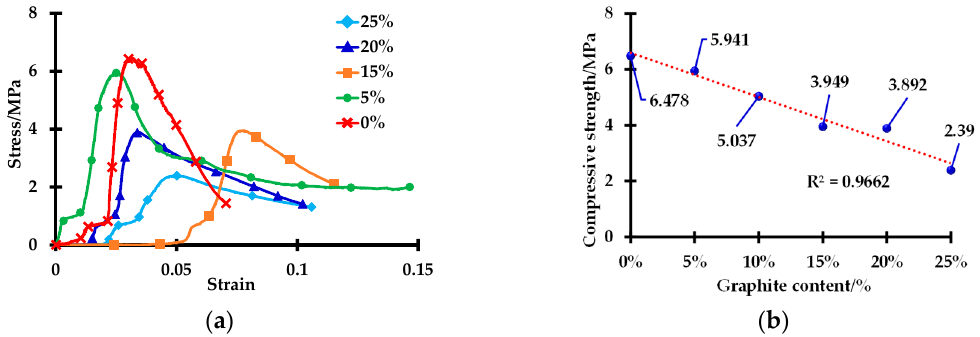
Figure 9. Effect of graphite content on the compressive strength of specimens. ( a ) Stress–strain; ( b ) relationship curve between strength and graphite content.